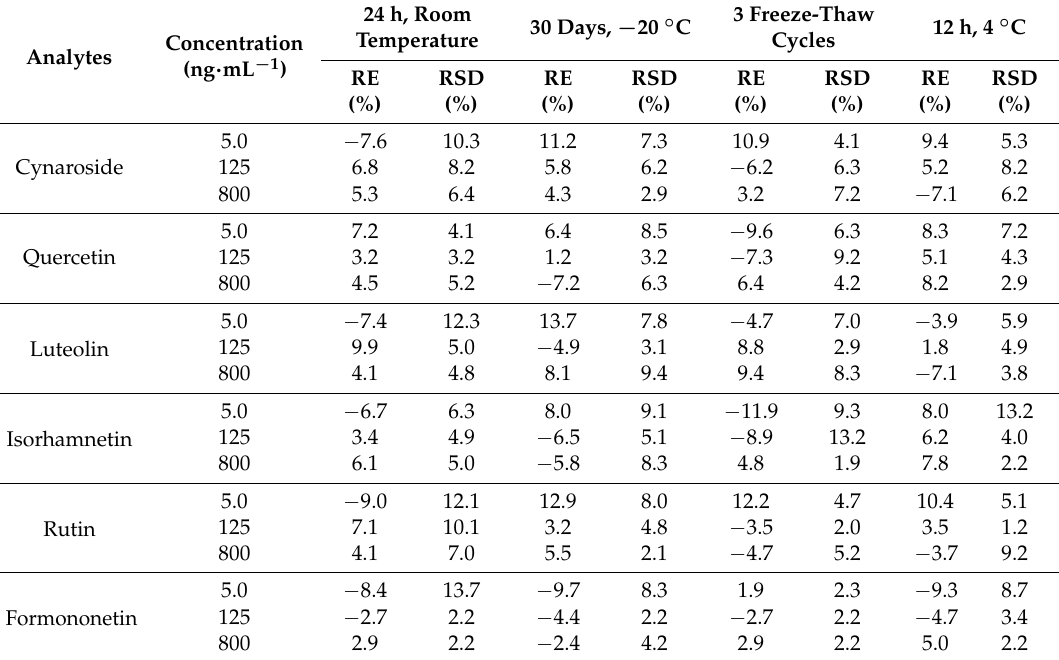
Table 3. Stability of the six analytes in rat plasma ( n =